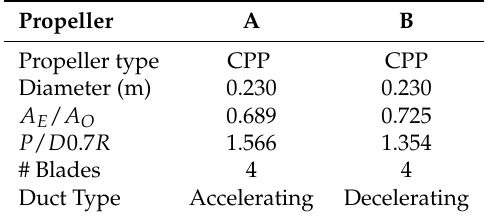
Table 1. Main parameters of the propellers and ducts analyzed in this